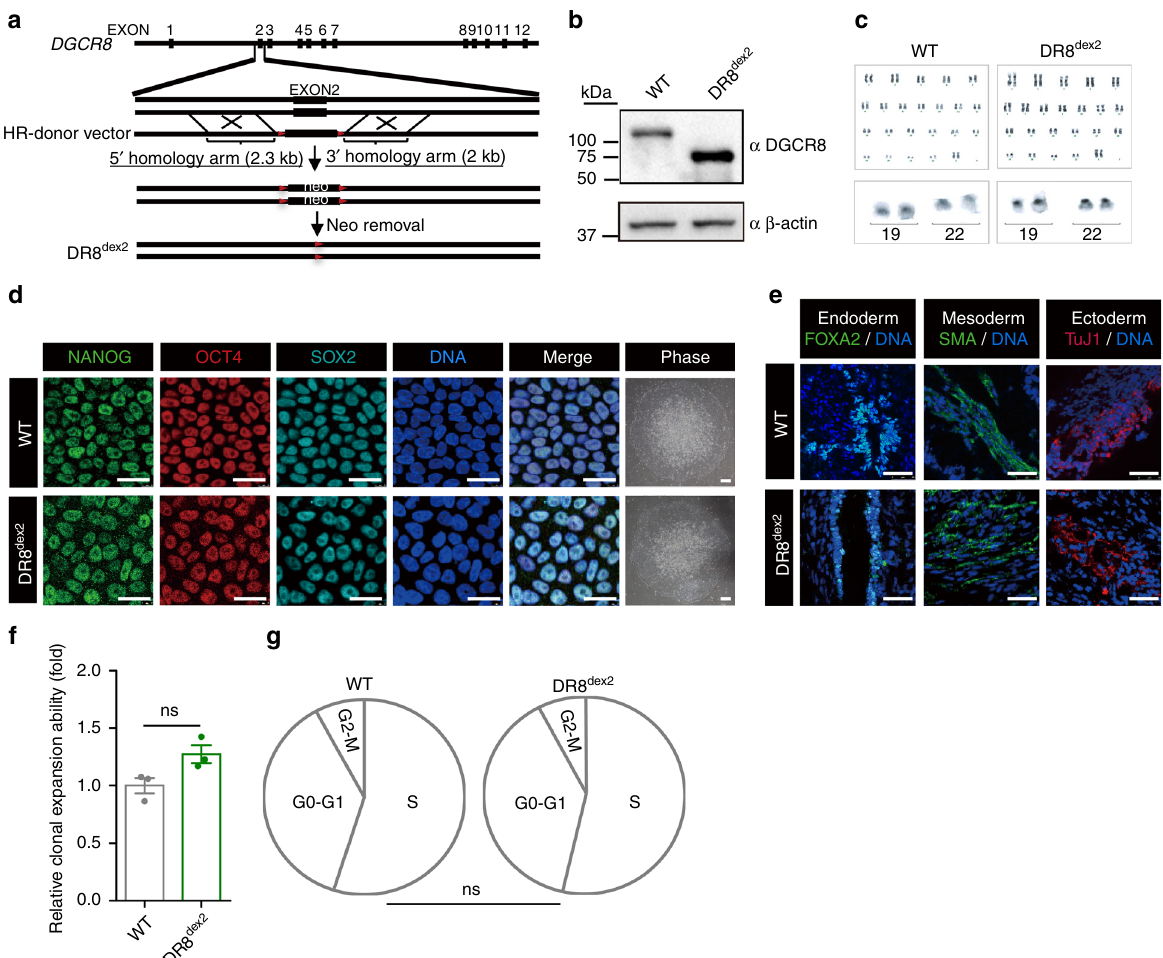
Fig. 1 CRISPR/Cas9-mediated gene targeting of DGCR8 in hESCs. a Schematic diagram of DGCR8 targeting using CRISPR/Cas9-mediated genome editing with homologous recombination. Neo stands for neomycin-resistance gene cassette used for positive selection. Red triangle indicates the FRT site. b Western blotting analysis of DGCR8 with protein extracts from WT and DR8 dex2 hESCs. β -actin was used as the loading control. c G-banded karyotyping analysis of WT and DR8 dex2 hESCs. d Immuno fl uorescence analysis of pluripotency markers OCT4, SOX2, and NANOG in WT and DR8 dex2 hESCs. Scale bar, 12.5 μ m. e Immuno fl uorescence analysis of representative markers of three germ layers in teratomas derived from WT or DR8 dex2 hESCs. Scale bar, 50 μ m. f Clonal expansion analysis of WT and DR8 dex2 hESCs. Data were presented as mean ± SEM. n = 3 wells per cell type, ns means no signi fi cance. g Cell cycle analysis of WT and DR8 dex2 hESCs. n = 3 wells per cell type, ns means no signi fi cance. Statistical signi fi cances were assessed by a